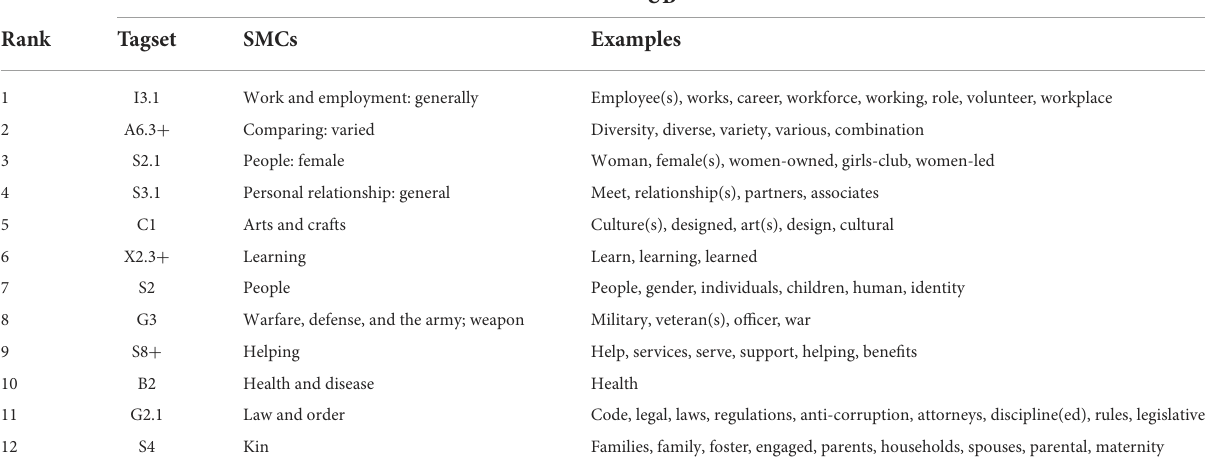
TABLE 7 Typical tokens of key semantic categories in